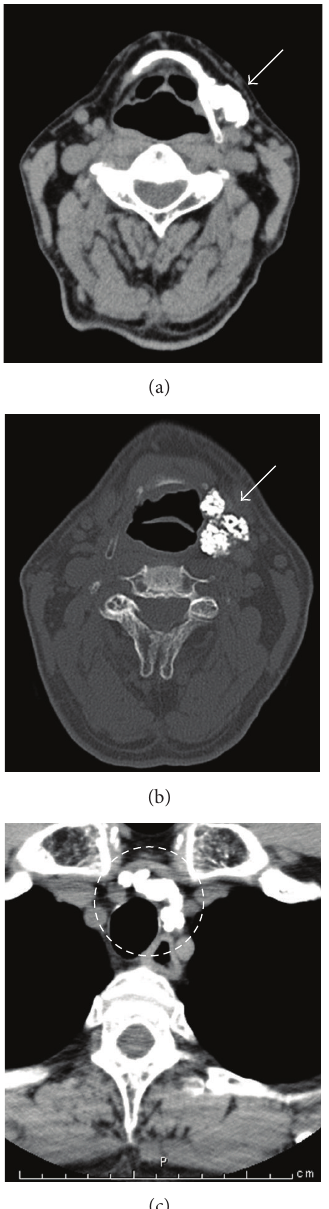
Figure 1: Neck and chest CT. Nodular shadows with calcification were observed (arrows in (a) and (b) and circles in (c)). ((a), (b)) Submandibular region. (c) Upper mediastinum.